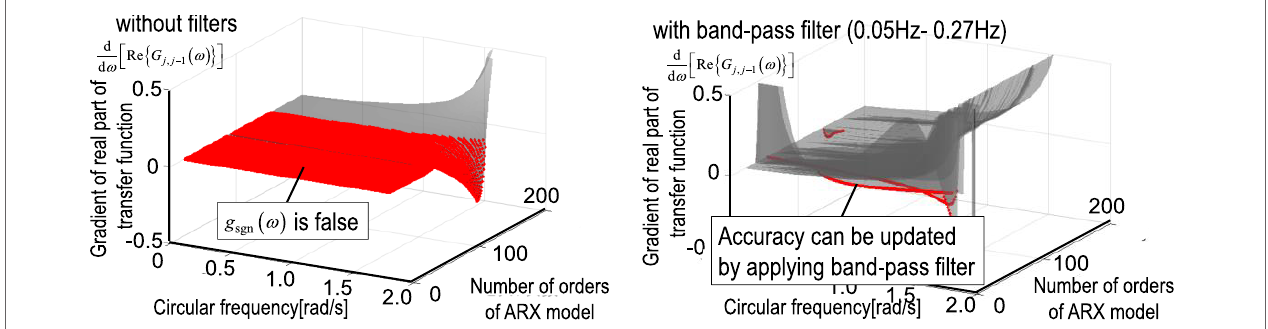
FIGURE 3 | Comparison of gradient of real part of transfer function d[Re{ G j , j (cid:0) 1 ( ω i )}]/d ω with and without filter .